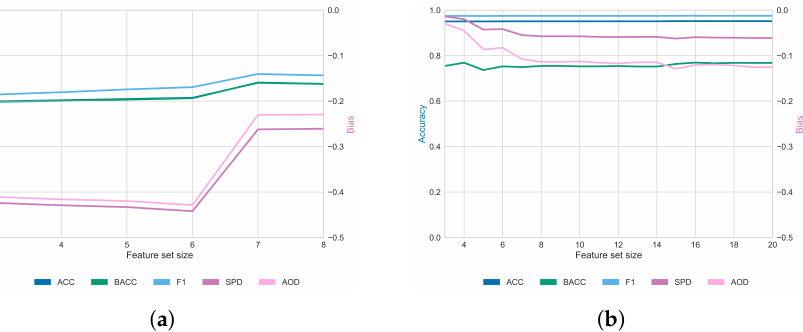
Figure 4. Performance results for LRC on different feature set sizes. Model performance was evaluated using stratified 10-fold CV. For SPD and AOD, values closer to zero indicate more fairness. ( a ) COMPAS; ( b ) LAW.